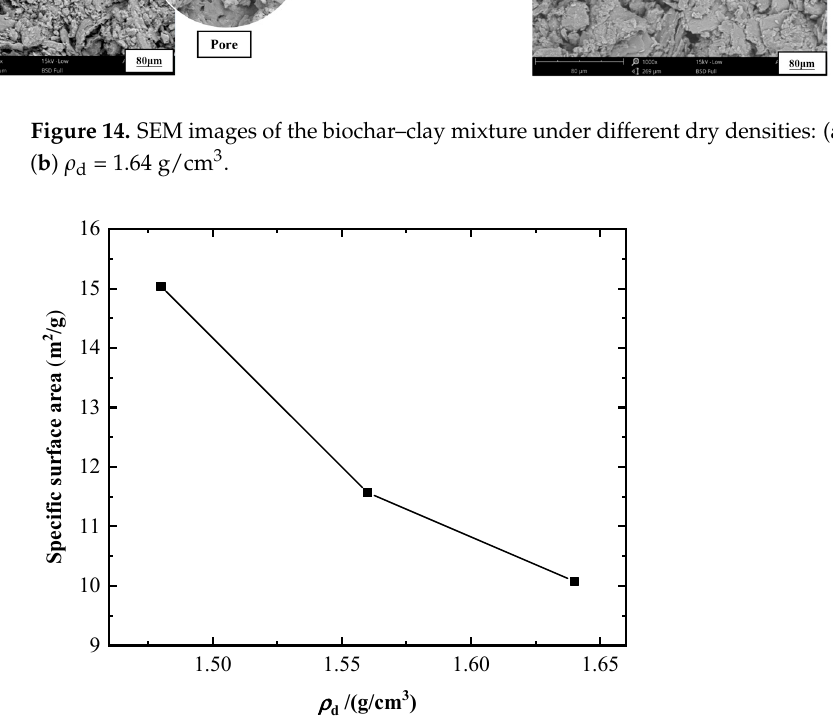
Figure 15. The specific surface area of the biochar–clay mixture under different dry densities.